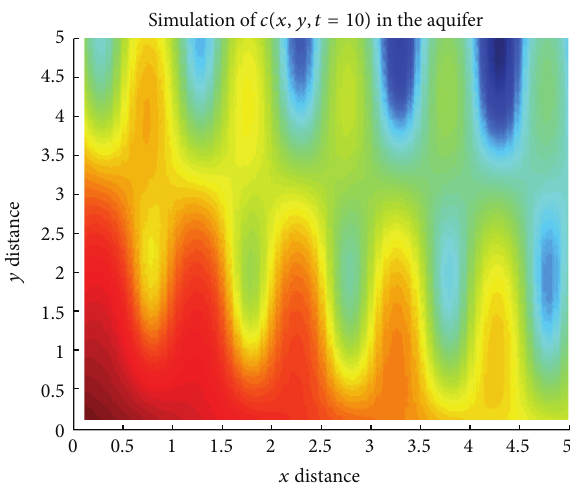
Figure 7: Contour plot of the approximated solution for a fixed time 𝑡 = 2 .